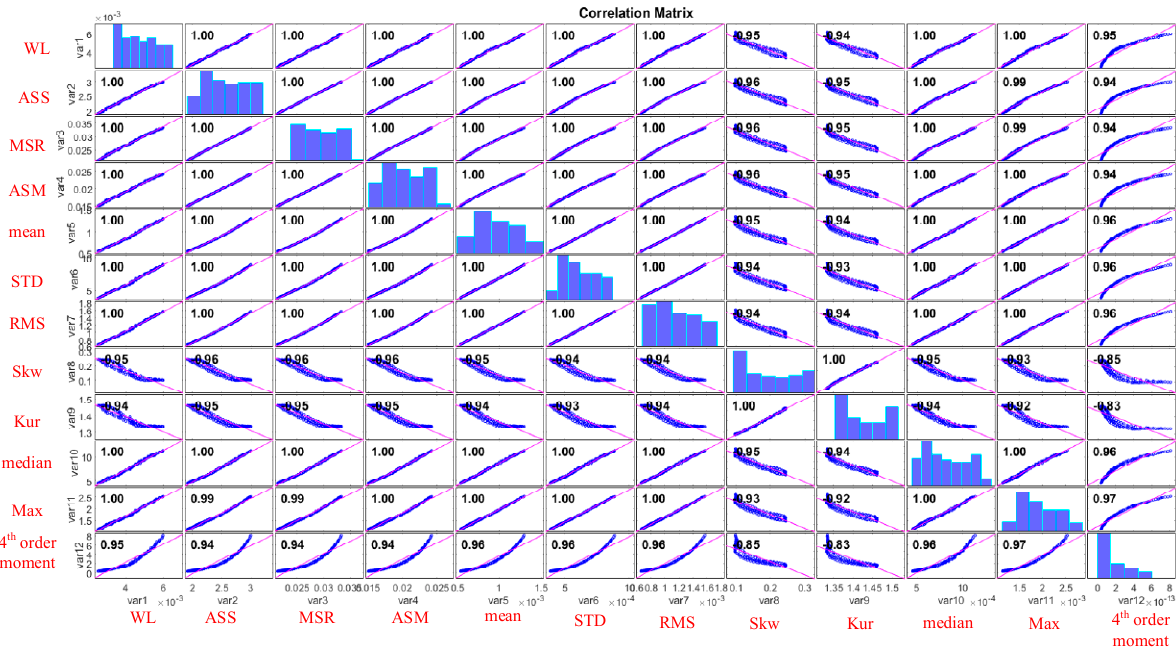
Figure 3. Results of the correlation analysis between all extracted characteristics.